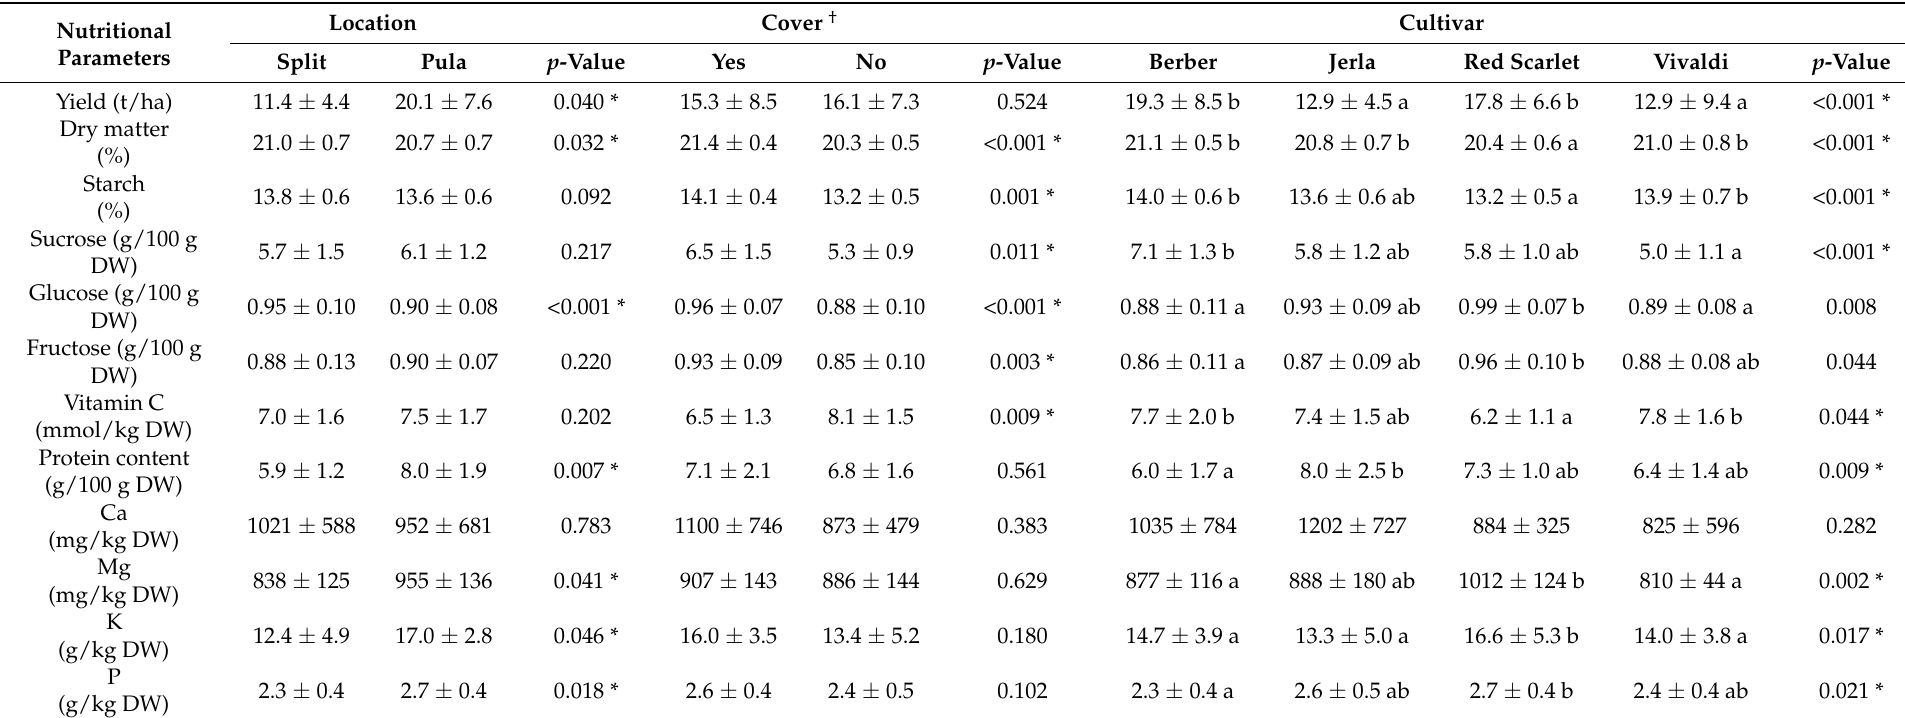
Table 2. Nutritional properties of potato tubers affected by location, plant cover and cultivar in the second year.